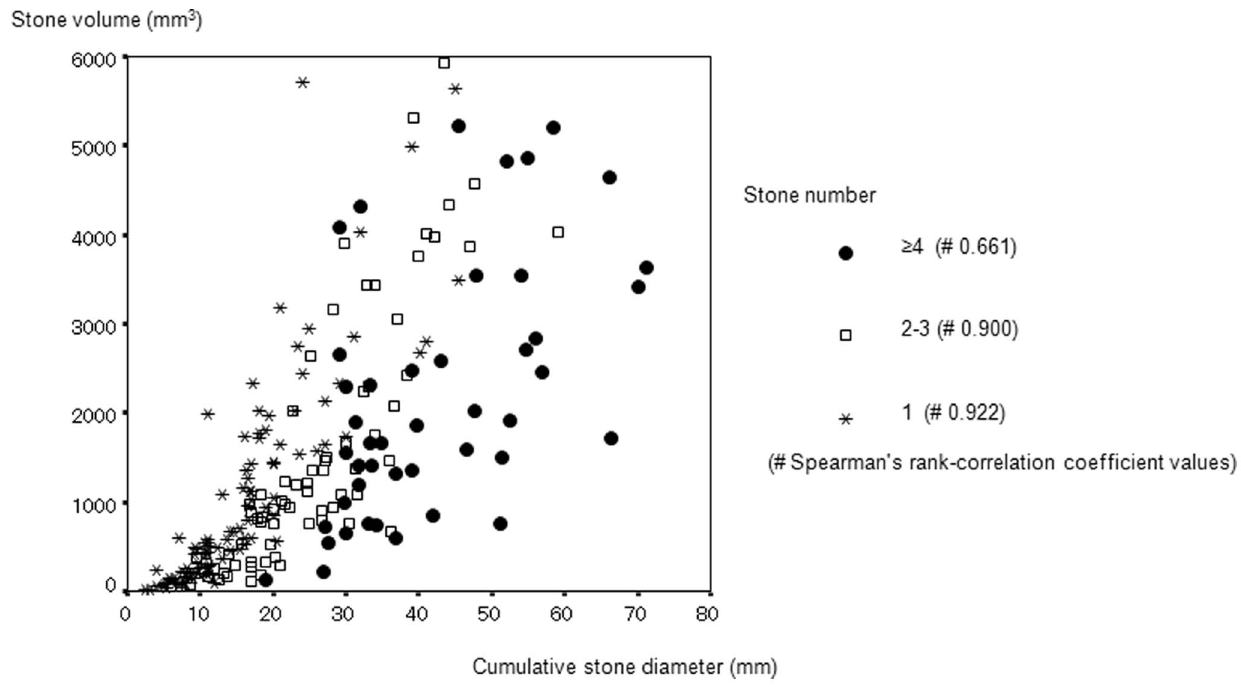
Figure 3. Scatter diagram using CSD and stone volume.